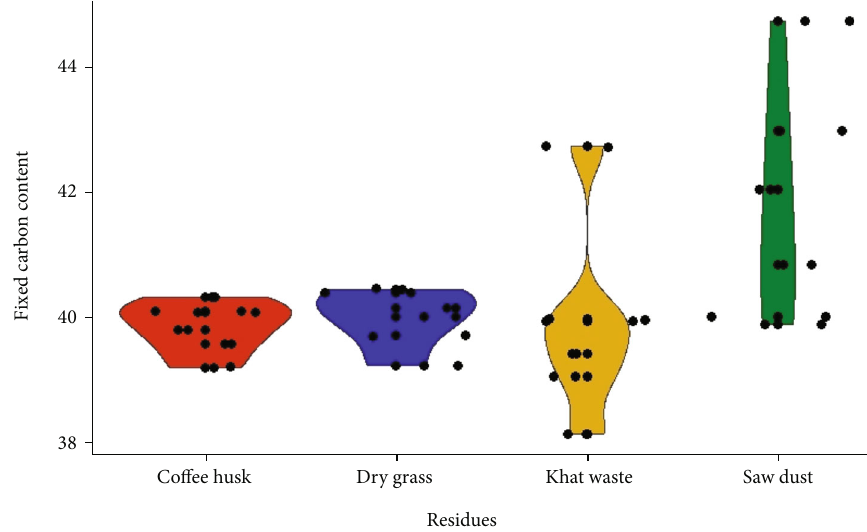
Figure 3: The e ff ect of produced briquettes on fi xed carbon